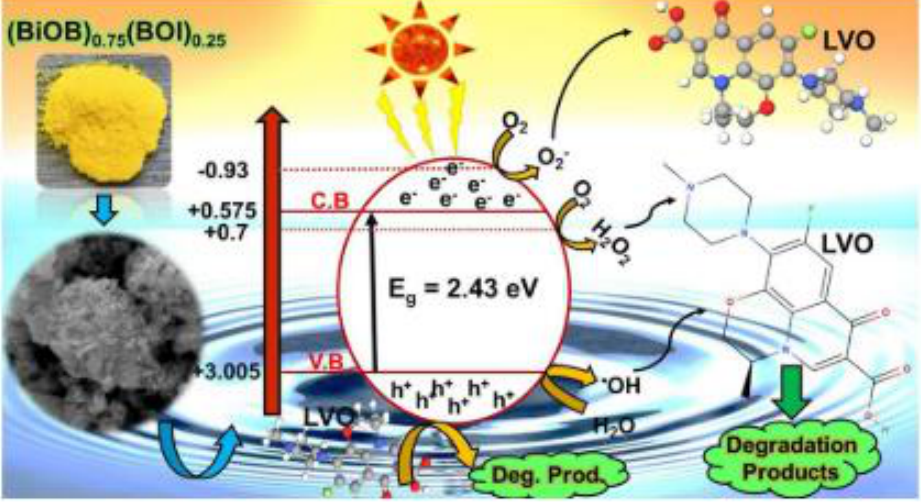
Figure 15. Reaction mechanism for sunlight photocatalytic degradation of antibiotic levofloxacin over (BOB) 0.75 (BOI) 0.25-U solid-solution nano-photocatalyst. Reprinted with permission from [49].